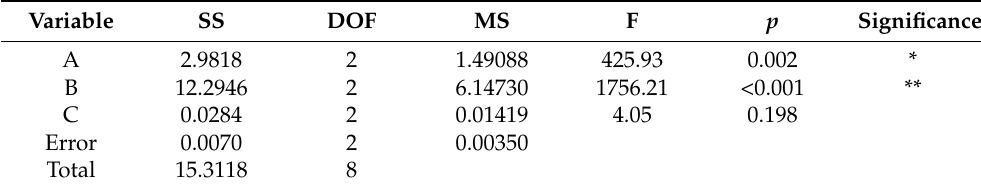
Table 5. ANOVA of crushing